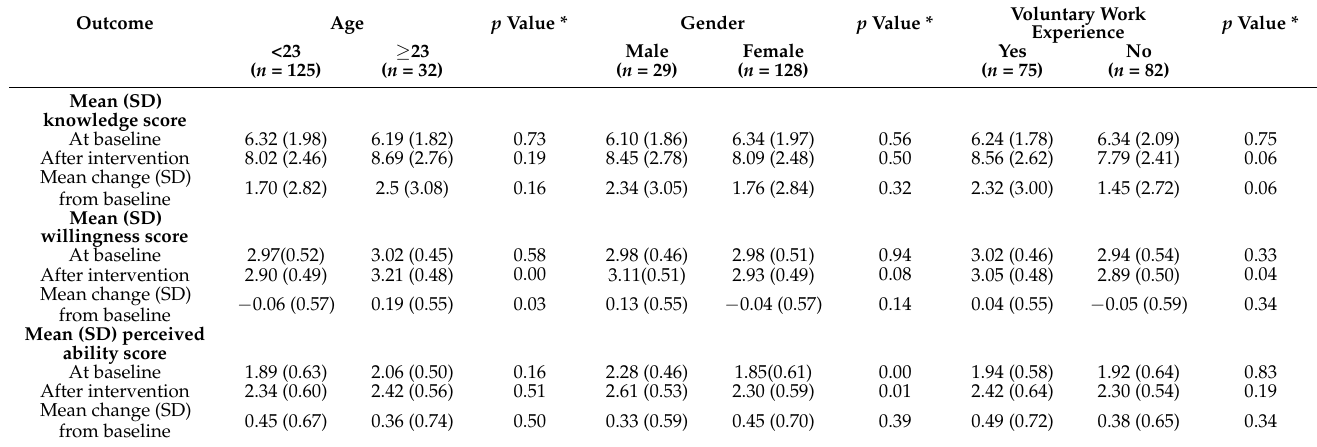
Table 5. Outcome of intervention by age, gender, and voluntary work